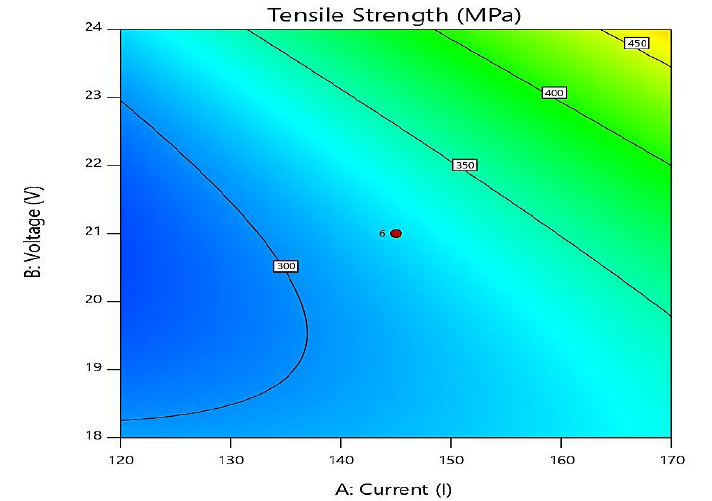
Fig. 3. Isoresponse contour plots showing effect of current, voltage and gas flow rate and their interactive effect on the tensile strength of mild steel plate.